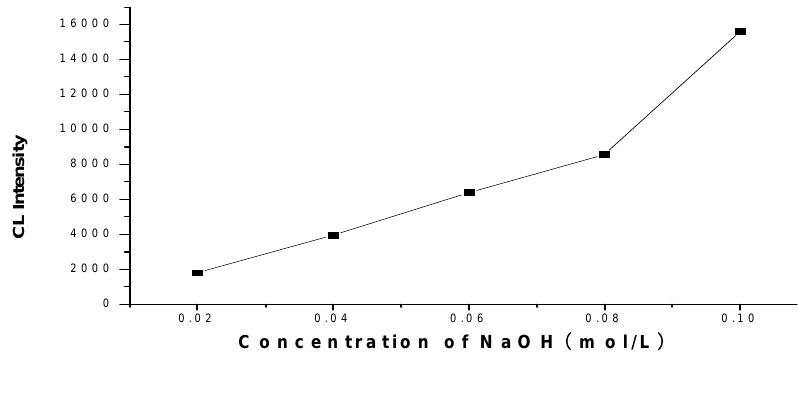
Figure 3. Effect of NaOH concentration on CL intensity (sample = 6